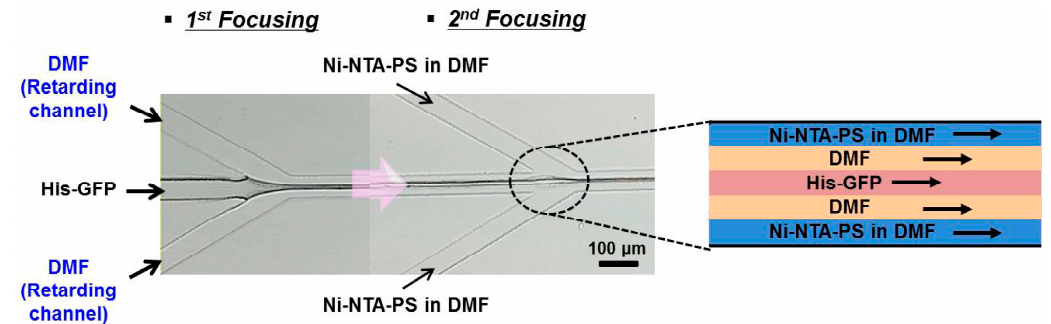
Figure 4. Multi-layered lamination flow formed with two-step focusing channel.